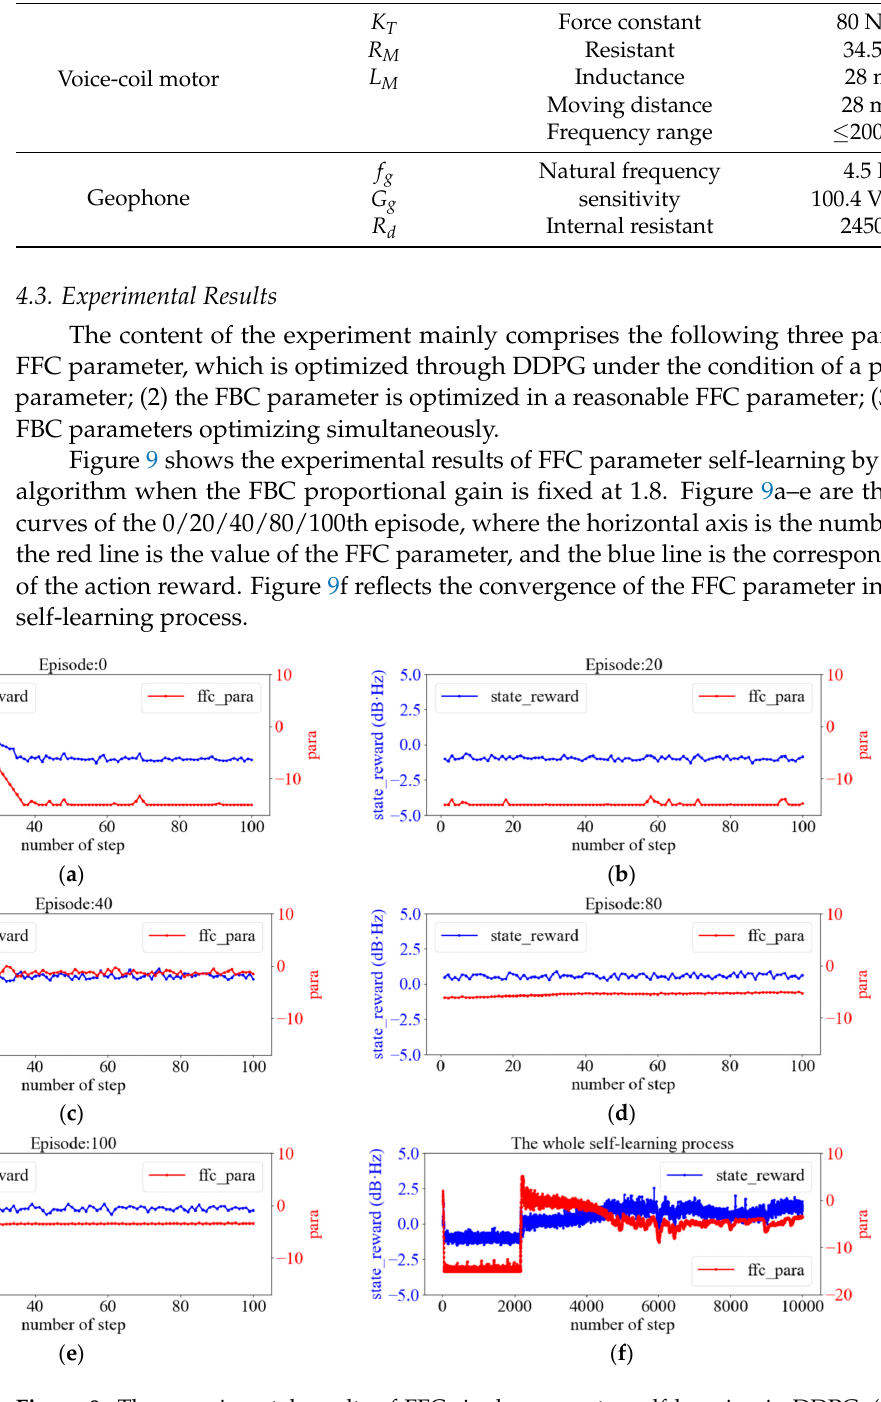
Figure 9. The experimental results of FFC single parameter self-learning in DDPG: ( a – e ) are the learning curves of the 0/20/40/80/100th episode, respectively; ( f ) are the curves of the whole self-learning